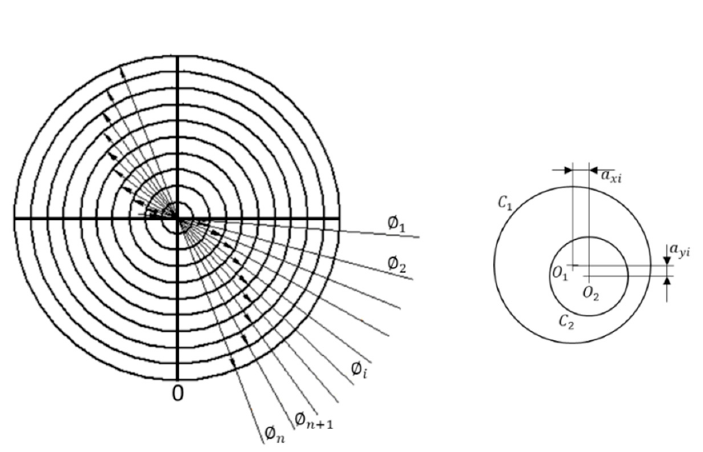
Figure 9. The dartboard model.